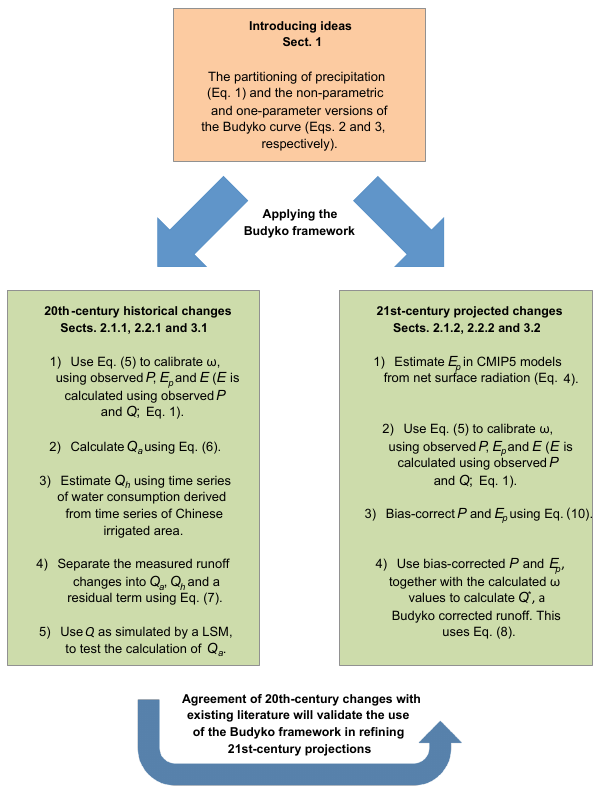
Figure 3. Schematic of how the Budyko framework is used to improve our understanding of 20th-century historical changes and 21st-century projected